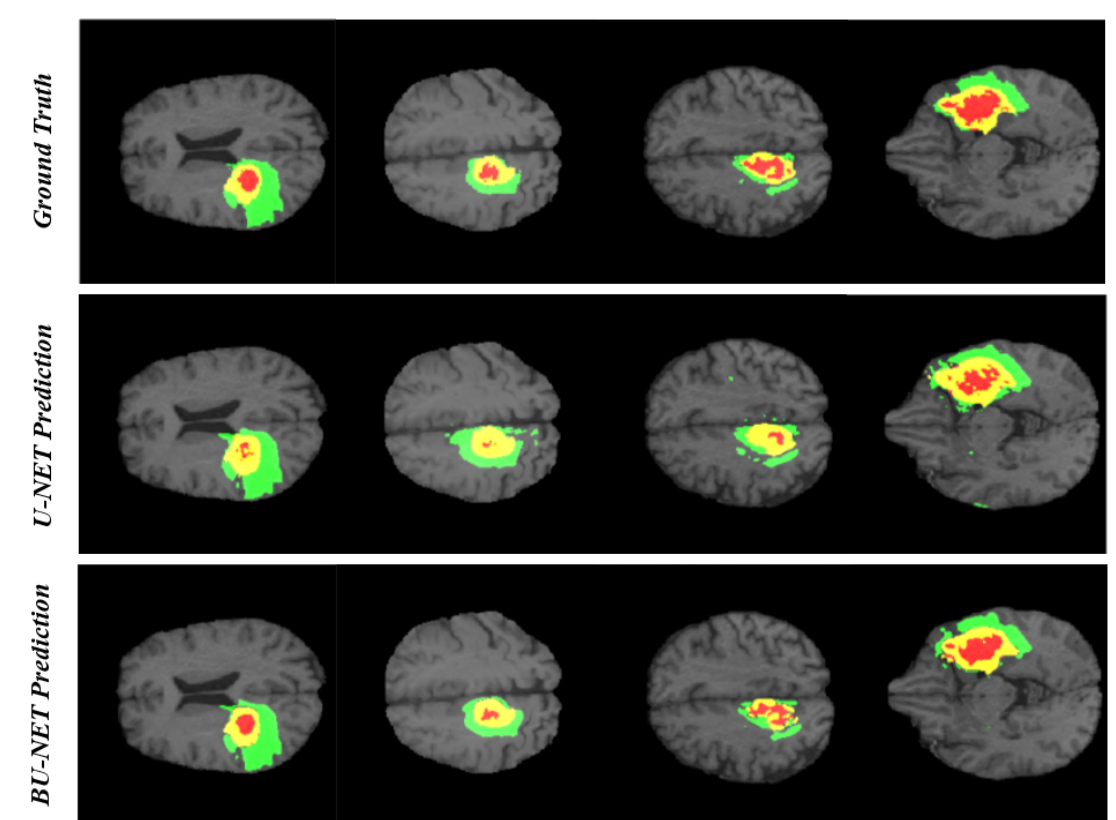
Figure 5. The qualitative analysis of BU-Net and U-Net. There are 3 colors used to represent three different tumor classes. Red represents necrosis and non-enhancing; green represents edema; and yellow represents an enhancing